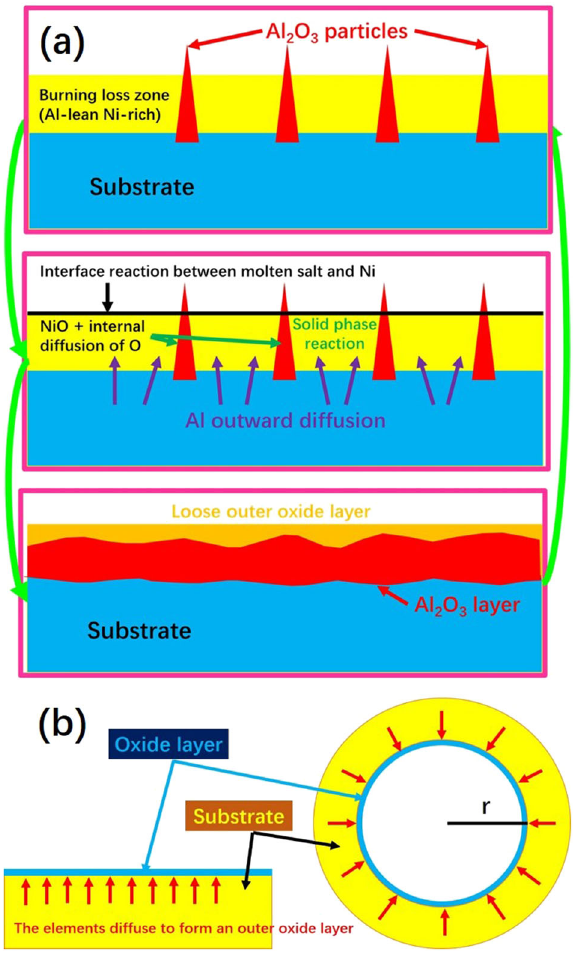
Fig. 9 The schematic diagram of the formation of oxide layer. a Oxide layer formation of hot corrosion after drilling and b oxide layer formation on different shaped surfaces after hot